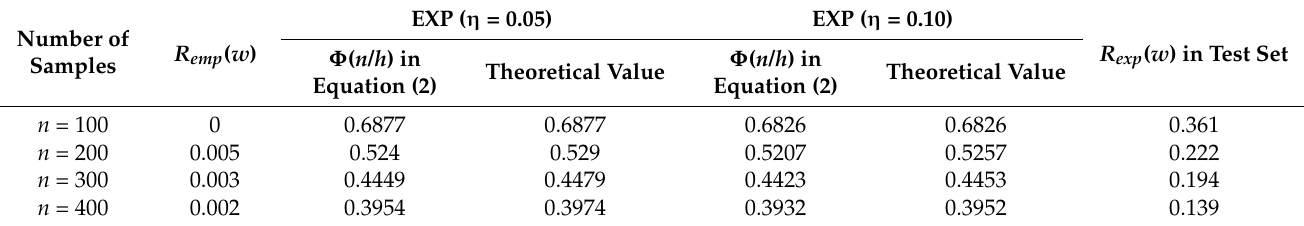
Table 1. Comparison of theoretical and actual values of R exp ( w ).